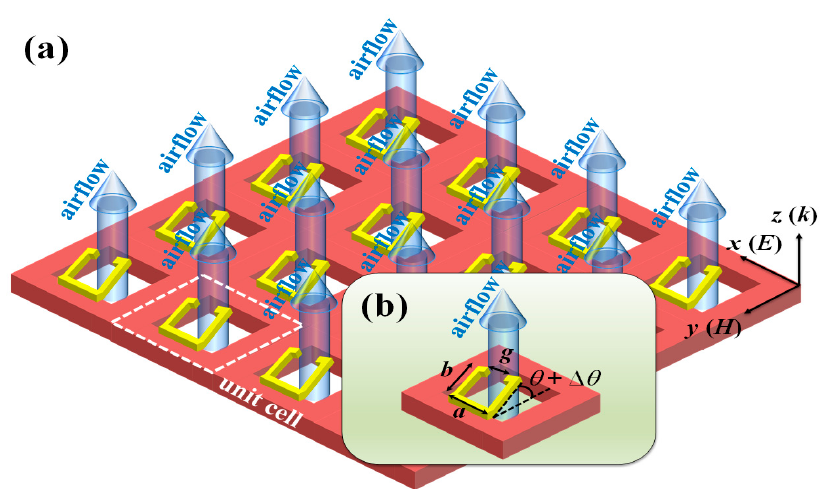
Figure 1. Schematic drawings of 3D MTM ( a) array and ( b ) unit cell for pressure sensing application. The geometric parameters of MTM are width ( a ), length ( b ), split ( g ), and the tilted angle of the cantilever ( θ ) of SRR.